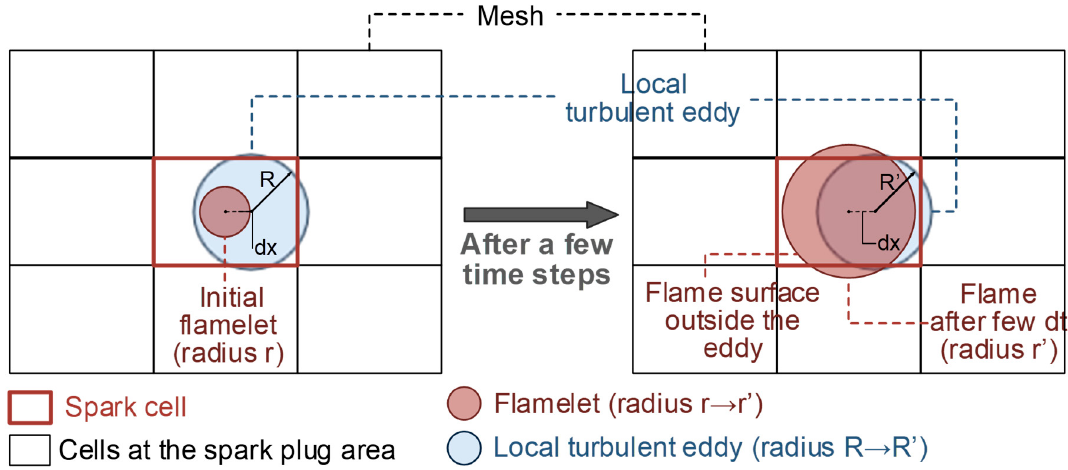
Figure 1. Relative location of initial flamelet and local turbulent eddy at the spark plug region. Left part : at spark ignition; Right part : after a few time steps.